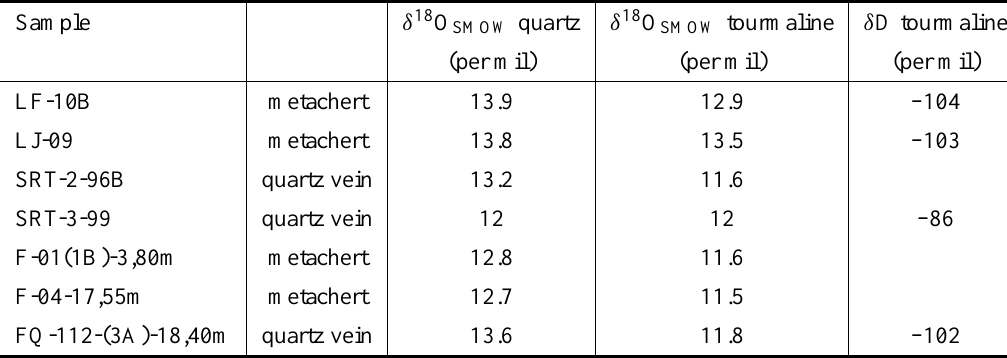
from Tapera Grande and